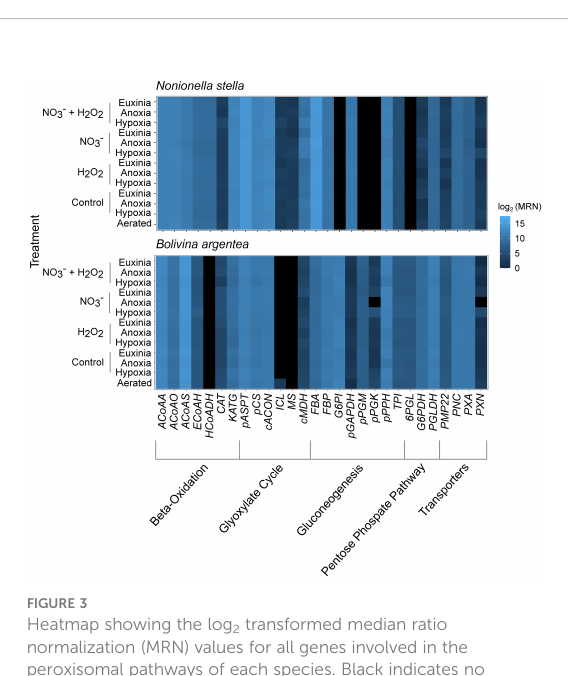
FIGURE 3 Heatmap showing the log 2 transformed median ratio normalization (MRN) values for all genes involved in the peroxisomal pathways of each species. Black indicates no expression. Abbreviations align with those in SI Table